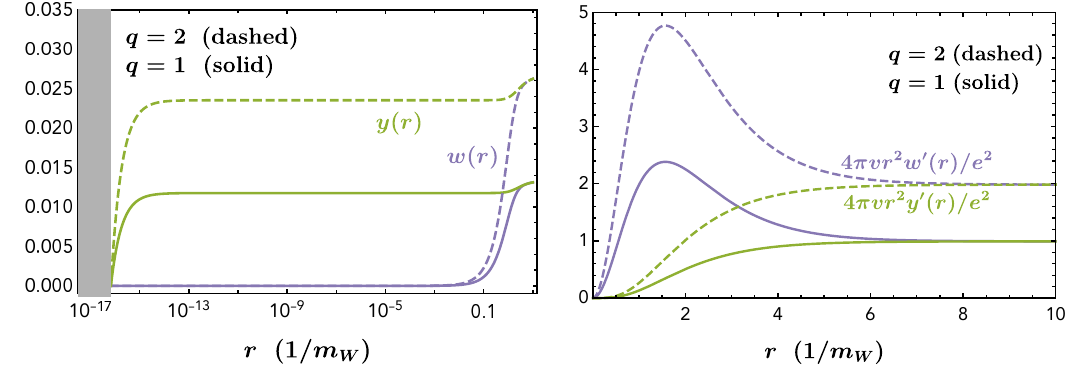
Figure 4 . Left: y ( r ) and w ( r ) as a function of r for the SM hairy dyonic black holes with an extremal √ black hole horizon r H = c W 4 π/ ( e M pl ) . The profiles for other functions are approximately the same as in the left panel of figure 1. Right: the effective charges related to the two neutral gauge fields as a function of r